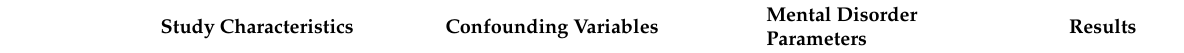
Table 1. Study characteristics and key